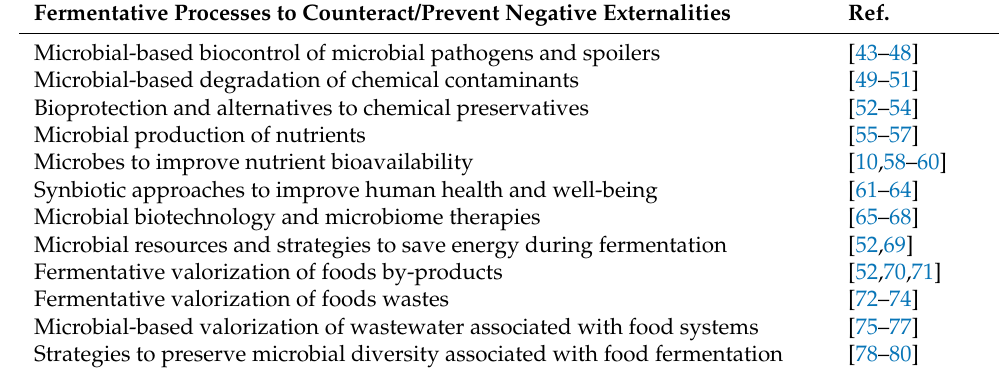
Table 3. A non-exhaustive list of possible microbial-based solutions as potential mitigating strategies against negative